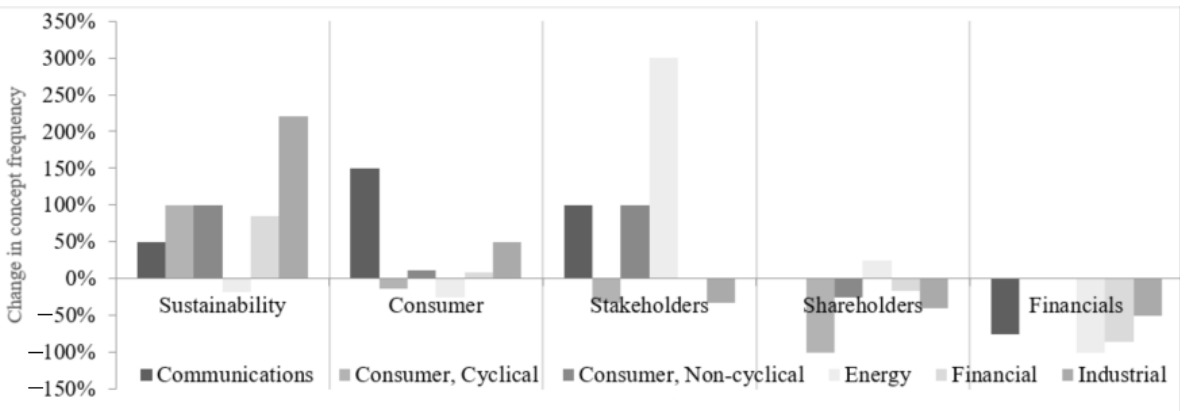
Figure 4. Results of the like-for-like mission statement analysis summarizing the changes in topic category occurrence in the companies’ mission statements over the time period from 2012 to 2021 sorted by industries—created by